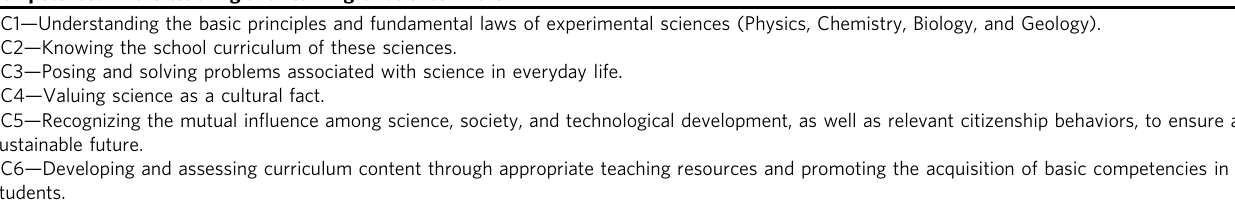
Table 1 Speci fi c competences of DES in the